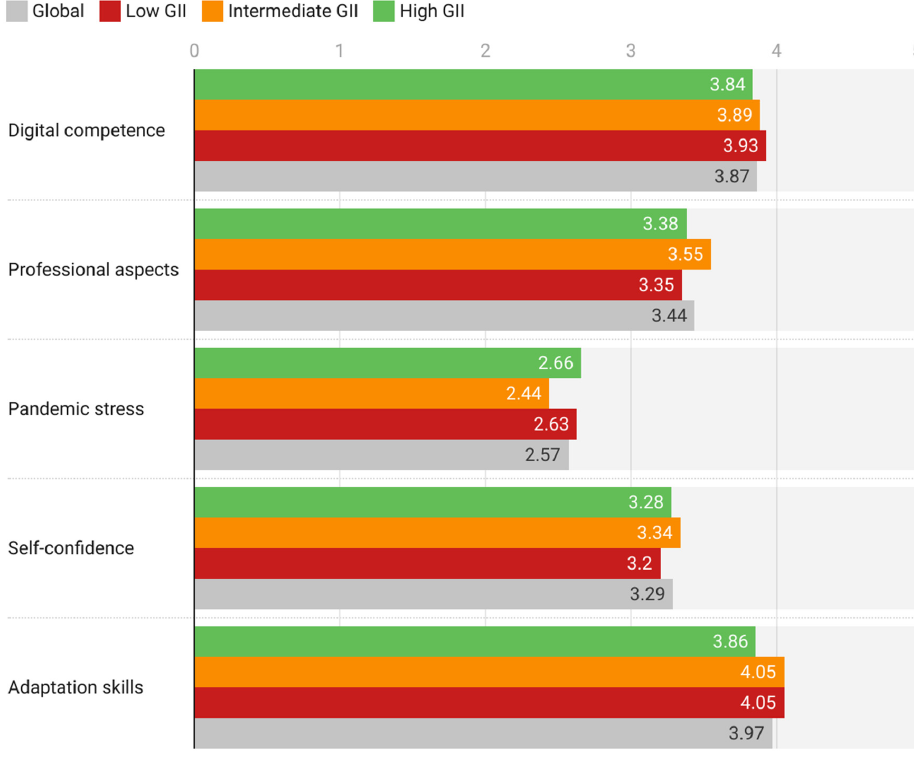
Figure 4. Mean values of the different subscales, globally and differentiated by GII area.